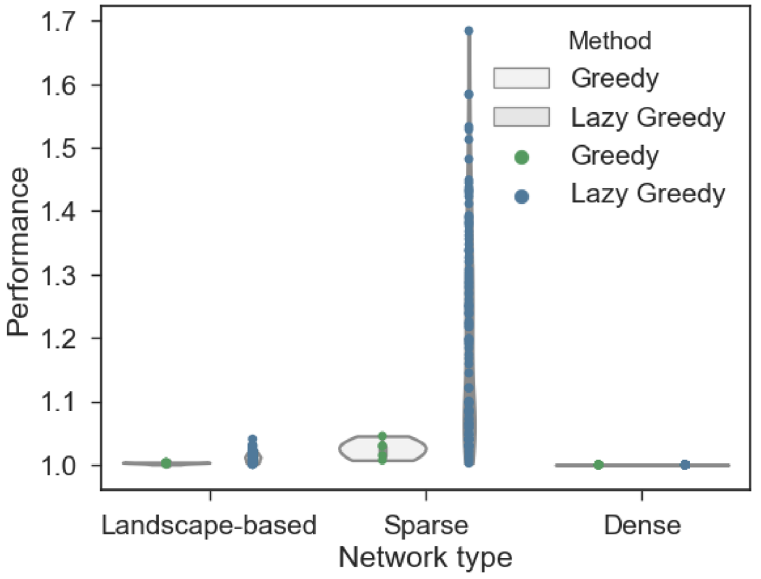
Fig 6. The Greedy algorithm returns an optimal solution in almost all cases. The vertical axis shows the quotient between optimal solution and solution of the heuristic. Only non optimal results are shown.